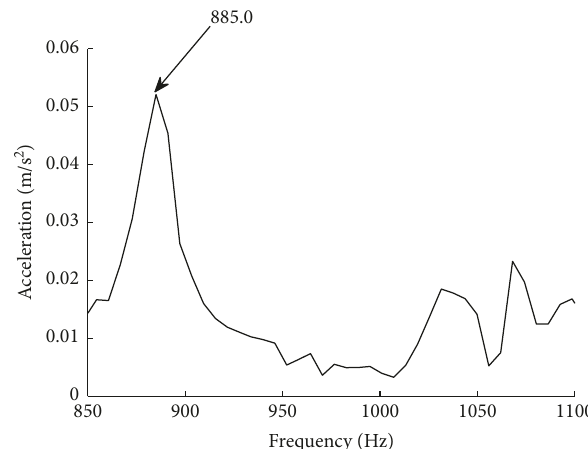
Figure 9: The acceleration-response spectrum corresponding to effective tension 110.8kN. (cid:31)